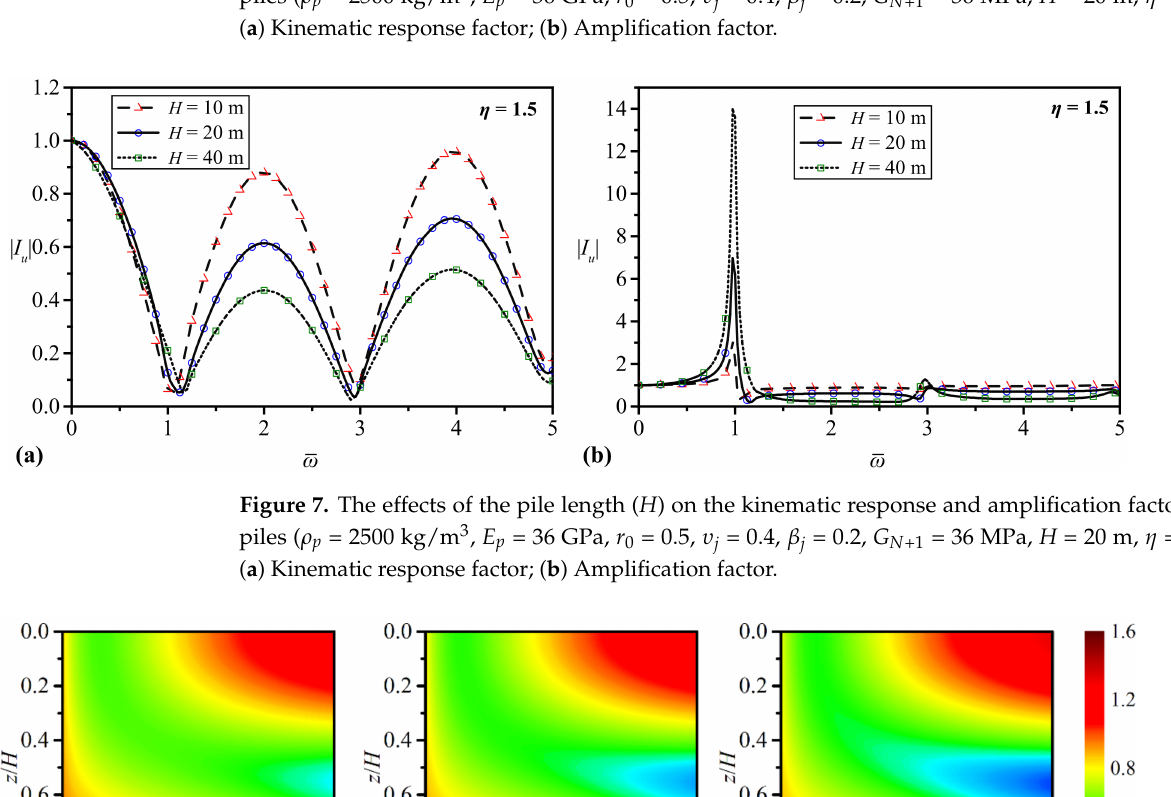
Figure 6. The effects of the pile length ( H ) on the kinematic response and amplification factors of piles ( ρ p = 2500 kg/m 3 , E p = 36 GPa, r 0 = 0.5, υ j = 0.4, β j = 0.2, G N +1 = 36 MPa, H = 20 m, η = 0.5).